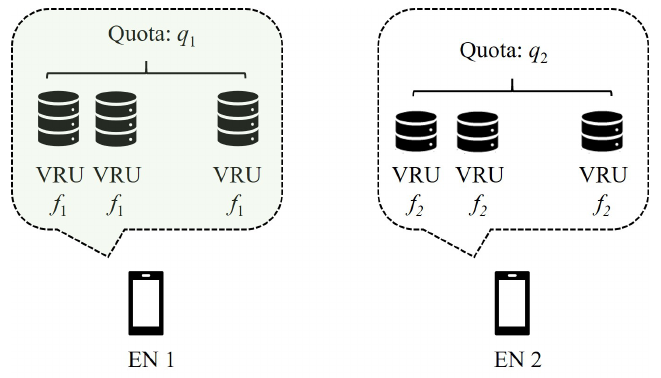
Figure 1. Heterogenous computational